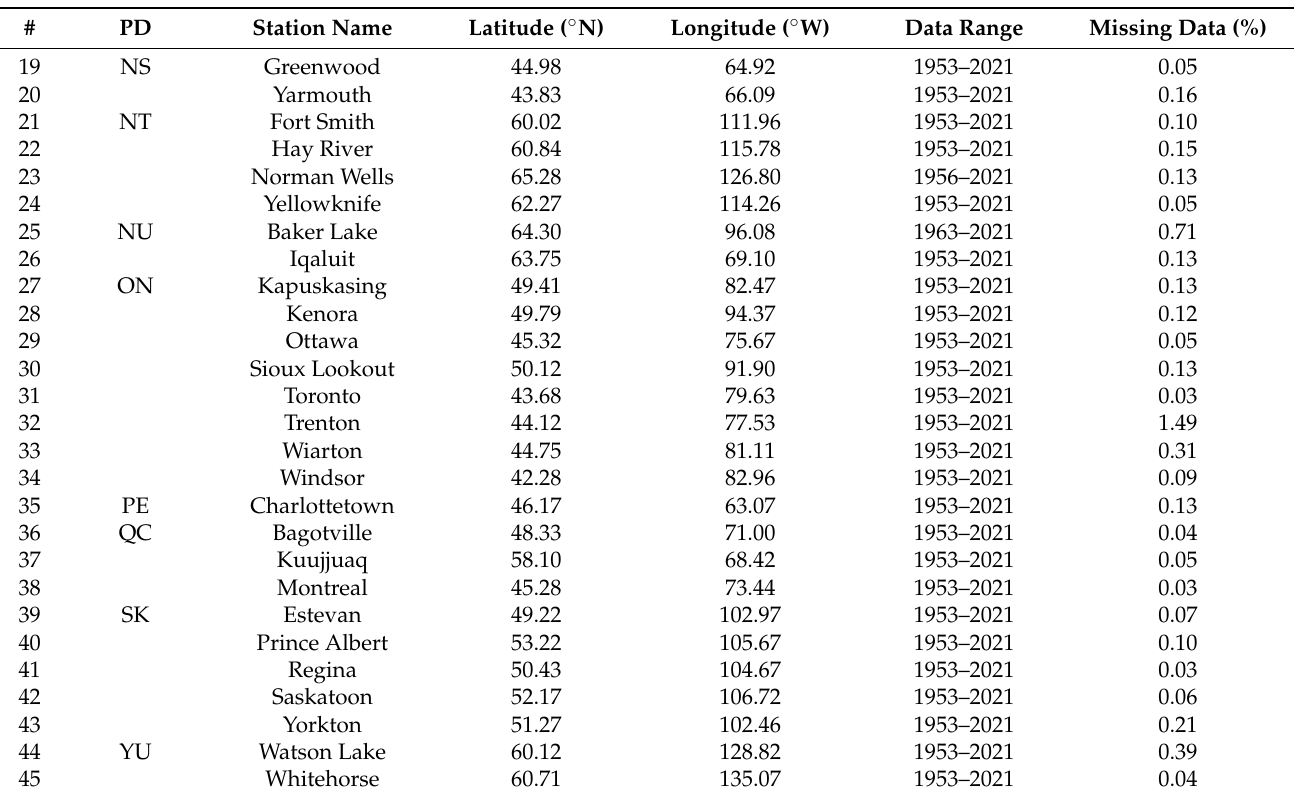
pattern, caused by the horizontal transport of cold or warm air. Typical advective days are characterized by either nearly equal diurnal extrema timing identified at sunrise or sunset delineations (1 to 4 h apart) or diametrically distant points (more than 20 h apart) at end-of-day